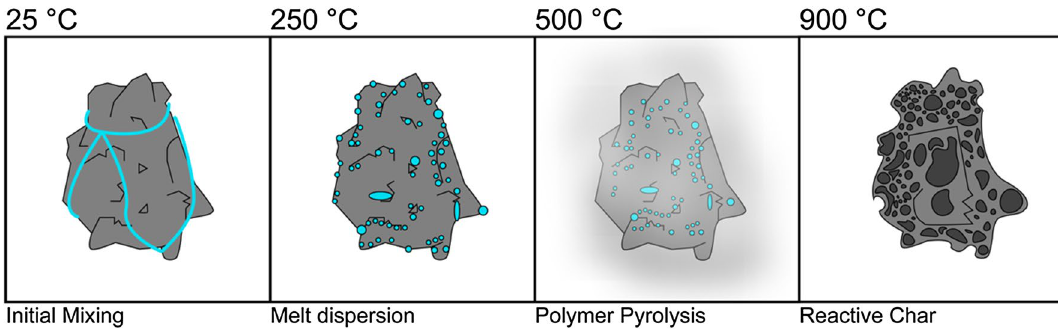
Figure 7. Proposed process schematic showing the effect of the polymer fabric of facemasks on a coal particle as it undergoes heat